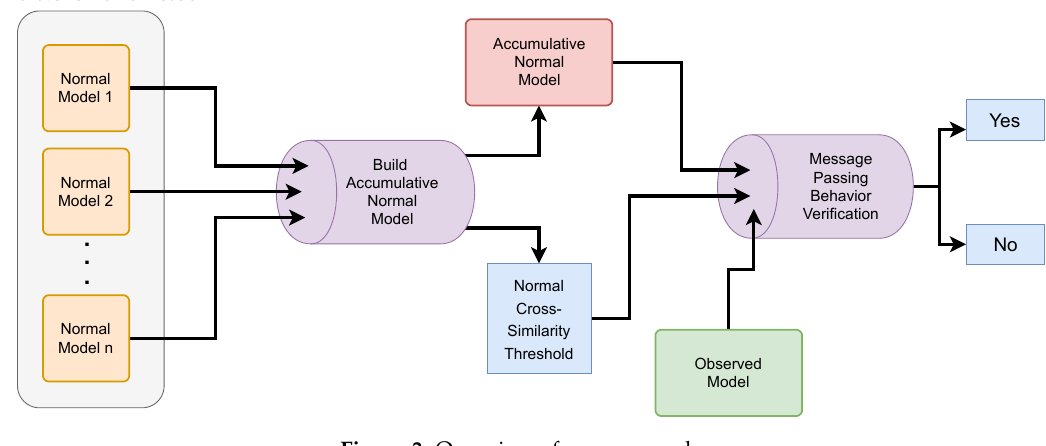
Figure 3. Overview of our